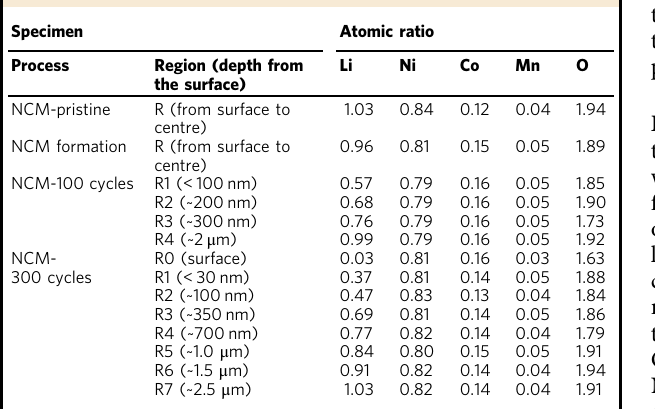
Table 2 Site-speci fi c quantitative APT results along the depth of pristine Li(Ni 0.80 Co 0.15 Mn 0.05 )O 2 (NCM) and NCM subjected to the formation, 100 cycles and 300 cycles (the atomic ratio is normalised to obtain a total metal fraction of